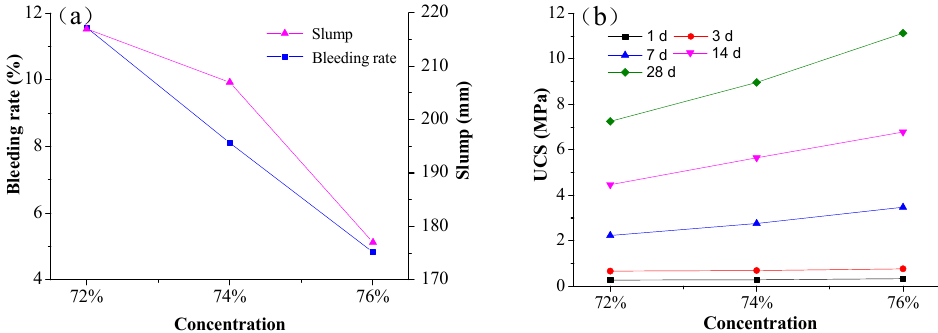
Figure 12. Effects of concentration on properties of filling material: ( a ) effects of concentration on transportation properties of filling material; ( b ) effects of concentration on mechanical properties of filling material.